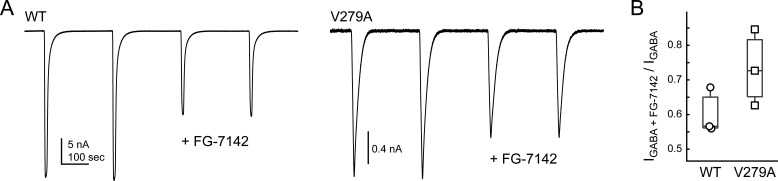
Reduction of GABA-evoked currents by the BZD negative modulator FG-7142 for α1β2γ2L (WT) and α1V279Aβ2γ2L (V279A) receptors.(A) Pair of current responses to 10 second pulses of ~EC20-25 GABA (WT: 10 μM, V279A: 30 μM) followed by a pair of responses to ~EC20-25 GABA + 1 μM FG-7142. (B) Summary of the ratio of peak currents as shown in (A) in the presence and absence of FG-7142 for individual oocytes. Gray box plots indicate the median and 25th and 75th percentiles.